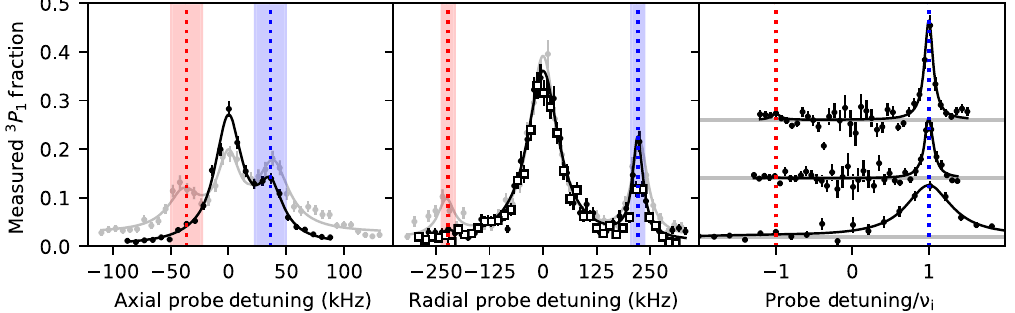
FIG. 3. Thermometry using sideband spectroscopy. When performing spectroscopy of the 1 S 0 ↔ 3 P 1 transition after sideband cooling, we observe a clear asymmetry in the strength of the heating and cooling motional sidebands along both the axial (left-hand panel, black trace) and radial (center panel) axes of our tweezer. These asymmetries correspond to ¯ n ¯ n ¼ 0 . 06 þ 0 . 26 ¼ 0 . 04 þ 0 . 20 and, ¯ n − 0 . 04 in each of the two radial directions probed (corresponding to the black points and line, and − 0 . 06 and r 1 r 2 white points, respectively, in the center panel). For comparison, spectra corresponding to trials without sideband cooling (though with narrow-line cooling from the three-dimensional MOT beams) are shown in gray; these indicate ¯ n Appendix D 2). The right-hand panel shows the spectra with the fitted contribution from the carrier transition subtracted. From top to bottom, the traces correspond to the first and second radial directions, and the axial direction. These traces are offset from zero for visibility, as indicated by the gray horizontal lines, with the frequency axis scaled by ν Where relevant, the red and blue lines (rectangles) in each panel denote the fitted center (full width half maximum) of the red and blue sidebands,